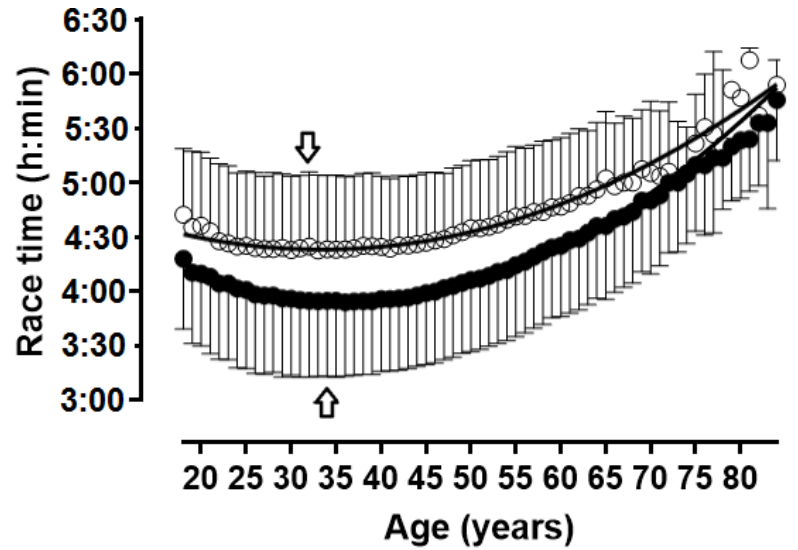
Figure 9. Race time in 1-year age groups. Arrows denote age of peak performance. Error bars represent standard deviations; = women, ⚫ = men.